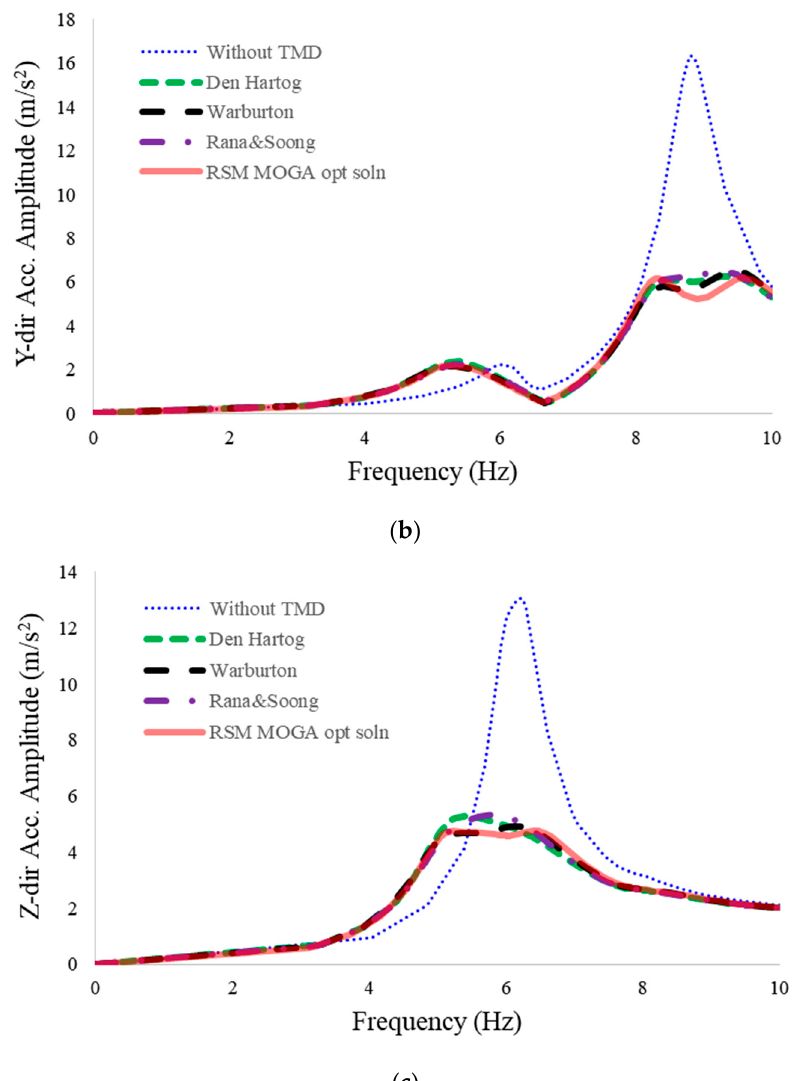
Figure 7. Comparison of the maximum frequency acceleration response at the TMD installation location of the piping: ( a ) X direction; ( b ) Y direction; ( c ) Z direction.